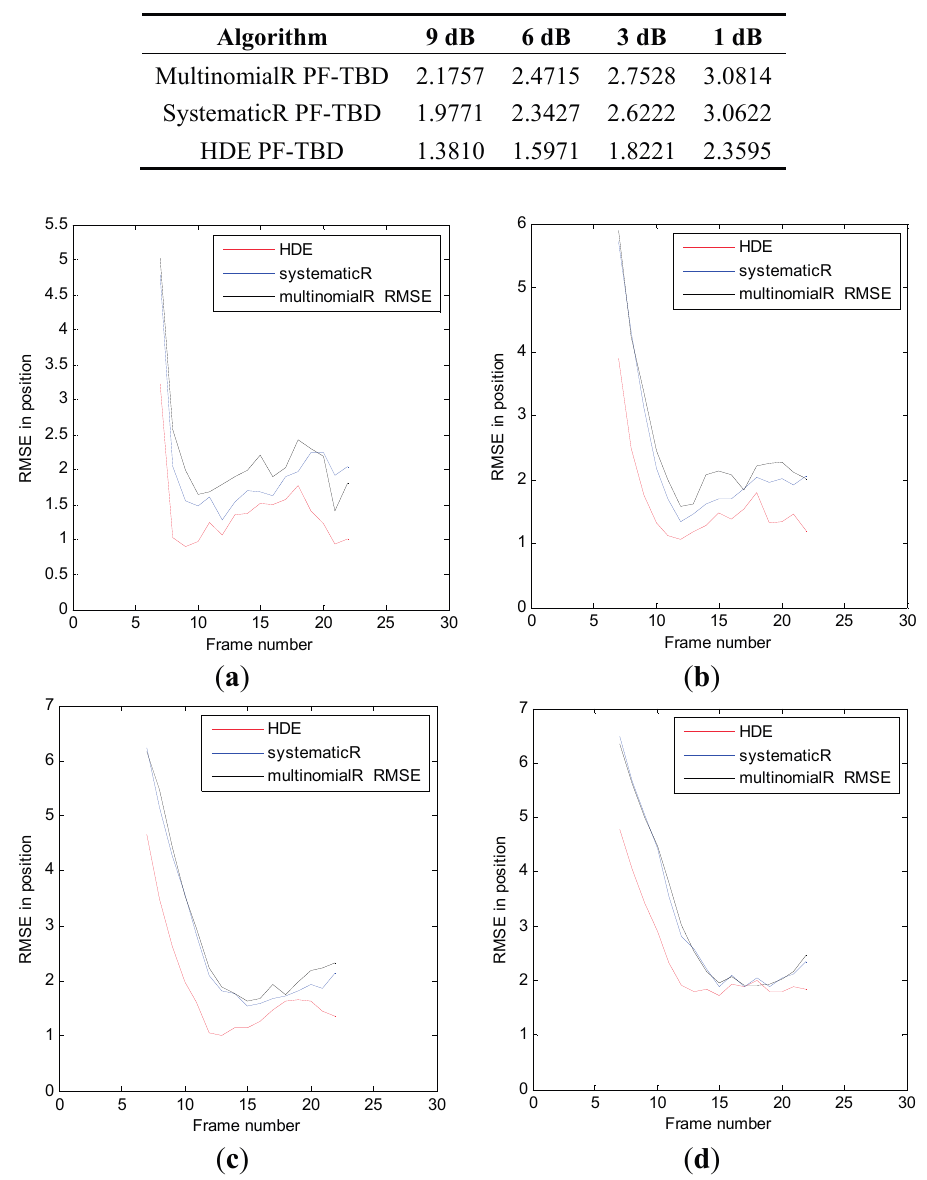
Figure 4. ( a ) RMSE in position at SNR = 9 dB for the CV model; ( b ) RMSE in position at SNR = 6 dB for the CV model; ( c ) RMSE in position at SNR = 3 dB for the CV model; ( d ) RMSE in the position of existence at SNR = 1 dB for the CV